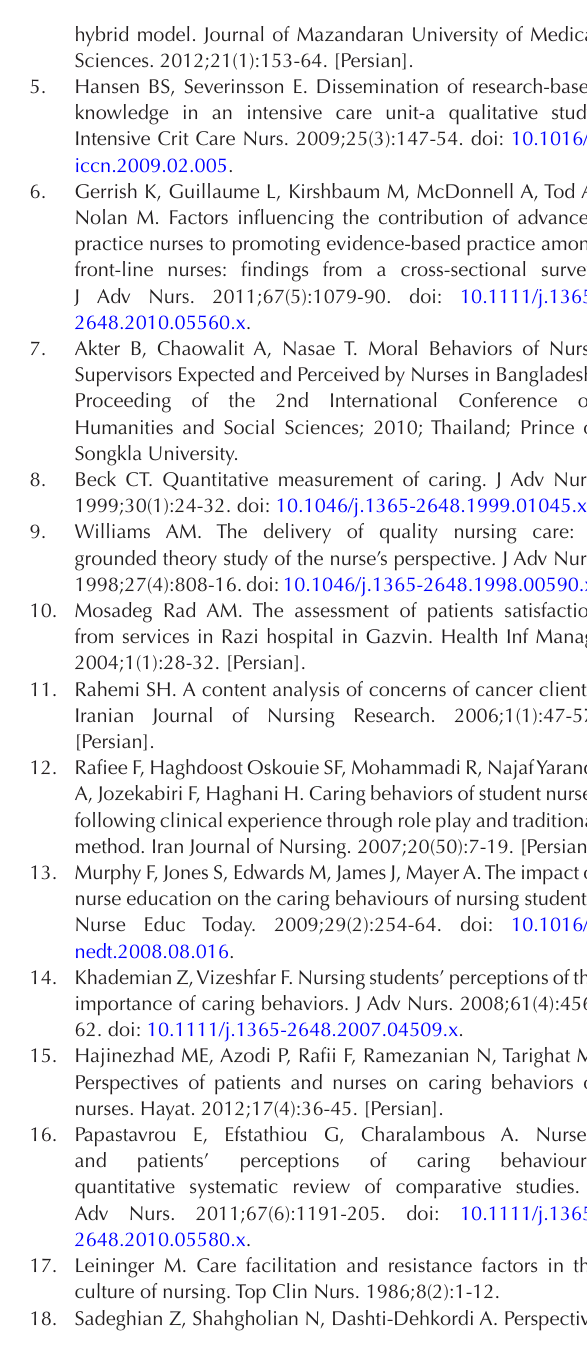
Dimensions of Caring